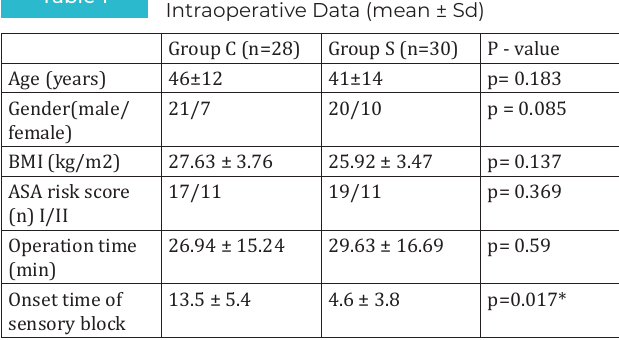
Patients’ General Characteristics and Intraoperative Data (mean ± Sd)